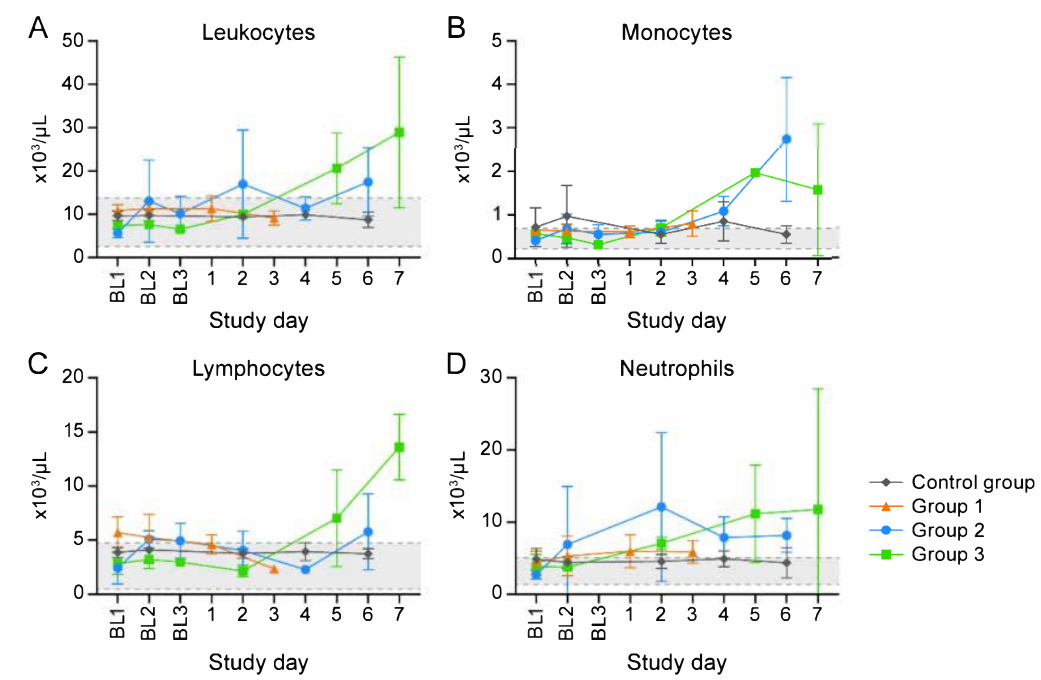
Figure 3. Clinical pathology supports inflammatory response. Total leukocyte ( A ), monocyte ( B ), lymphocyte ( C ), and neutrophil ( D ) number changes indicate inflammation. BL = baseline sampling, time points prior to intravenous (IV) cowpox virus (CPXV) exposure. Error bars reperesent standard deviation. Day 0 is not included on the graphs because no measurements were